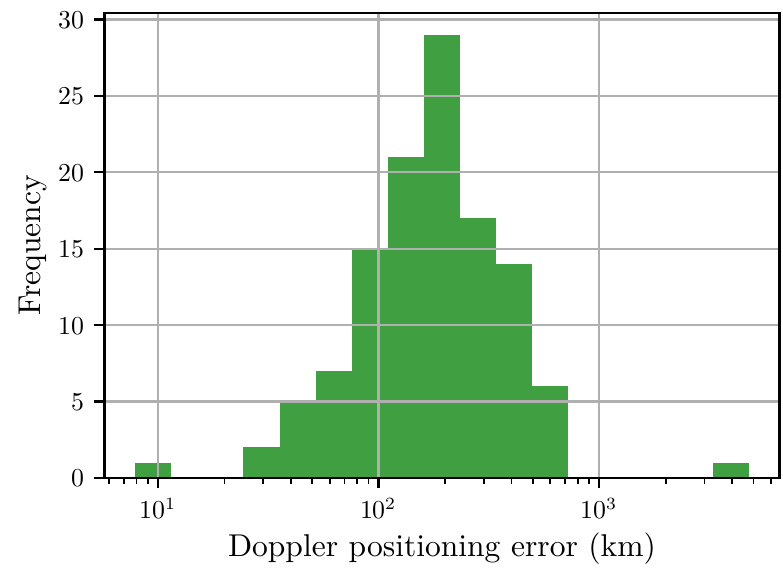
Figure 4. Histogram of Doppler position errors (in km) ( N = 118). The median Doppler-only positioning error is 175 km. The 95th percentile is 537 km. The vertical axis represents the number of doppler-fixes that fall within the corresponding range of positioning